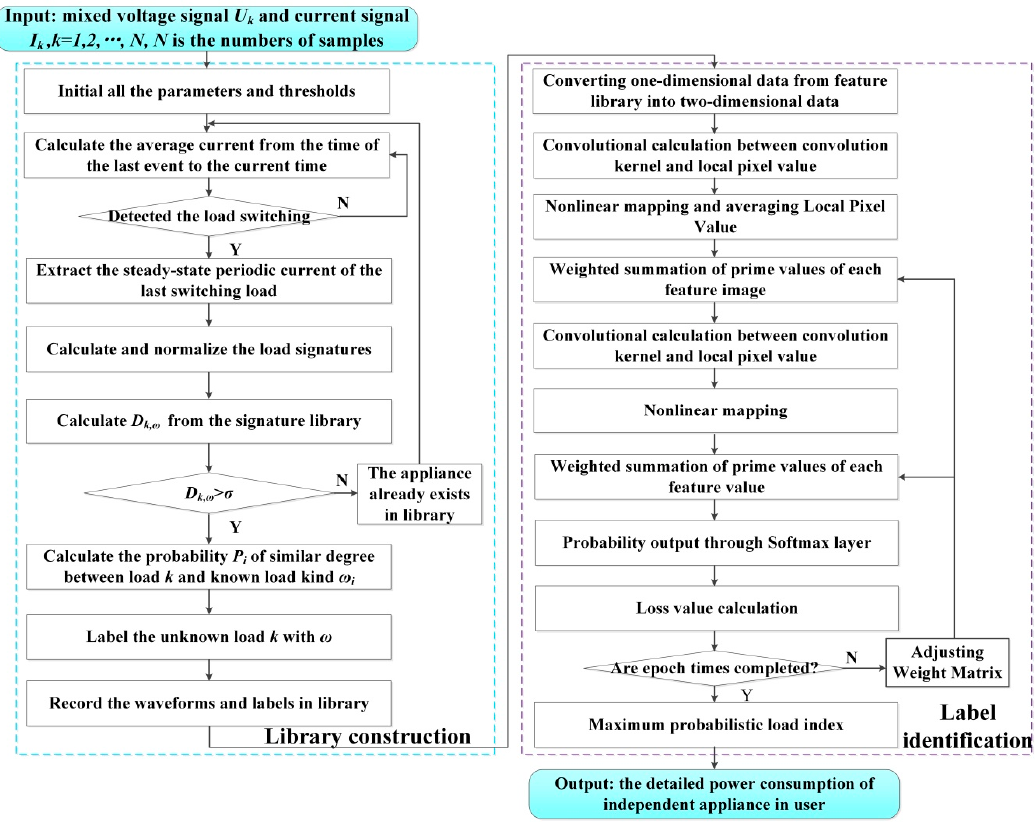
Figure 4. Overall algorithm flow chart.